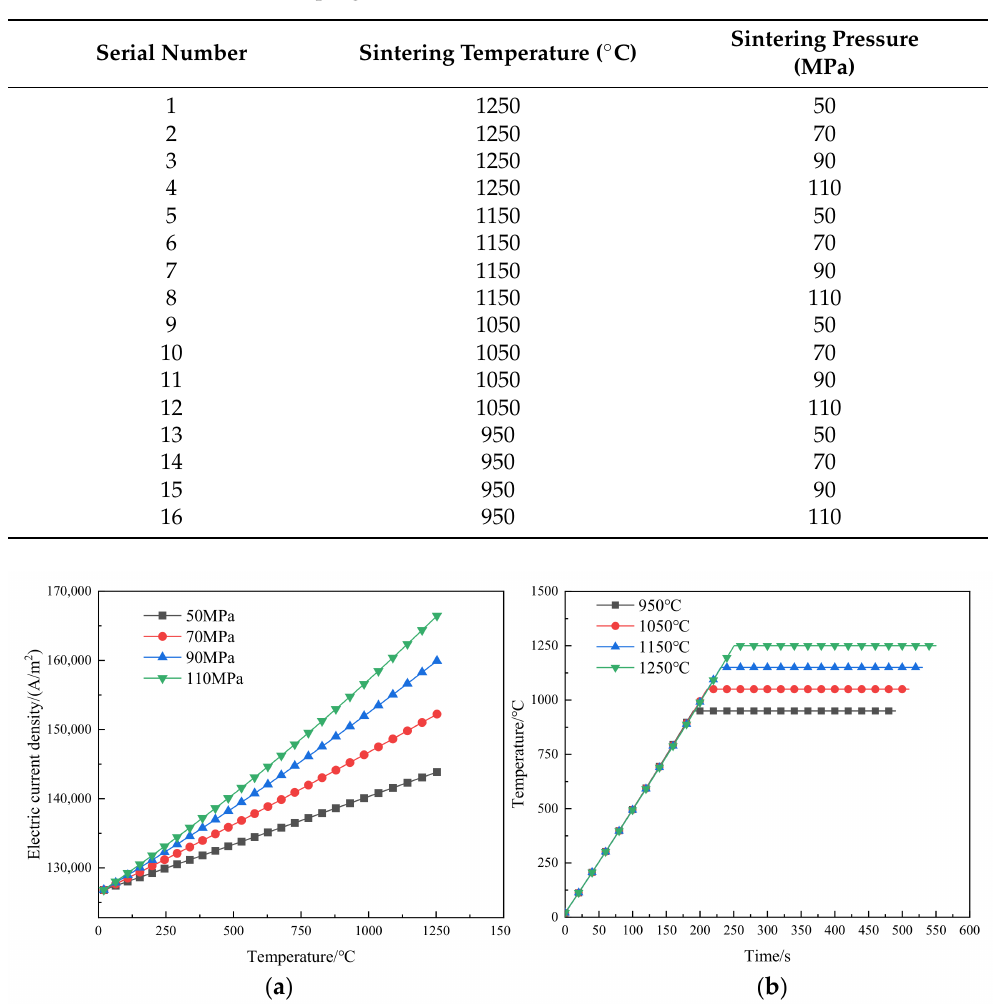
Table 2. Numerical simulation program.